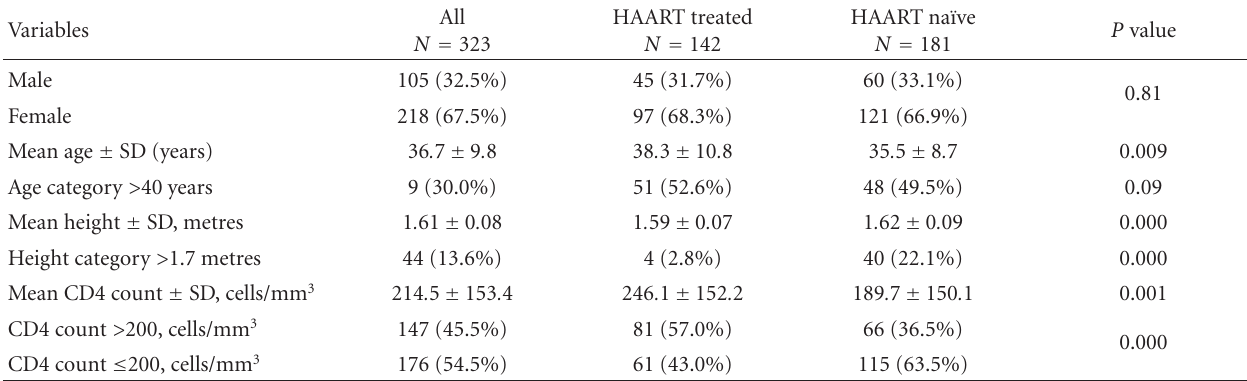
Table 1: Demographic and clinical characteristics of 323 participants in the HIV-SN study.